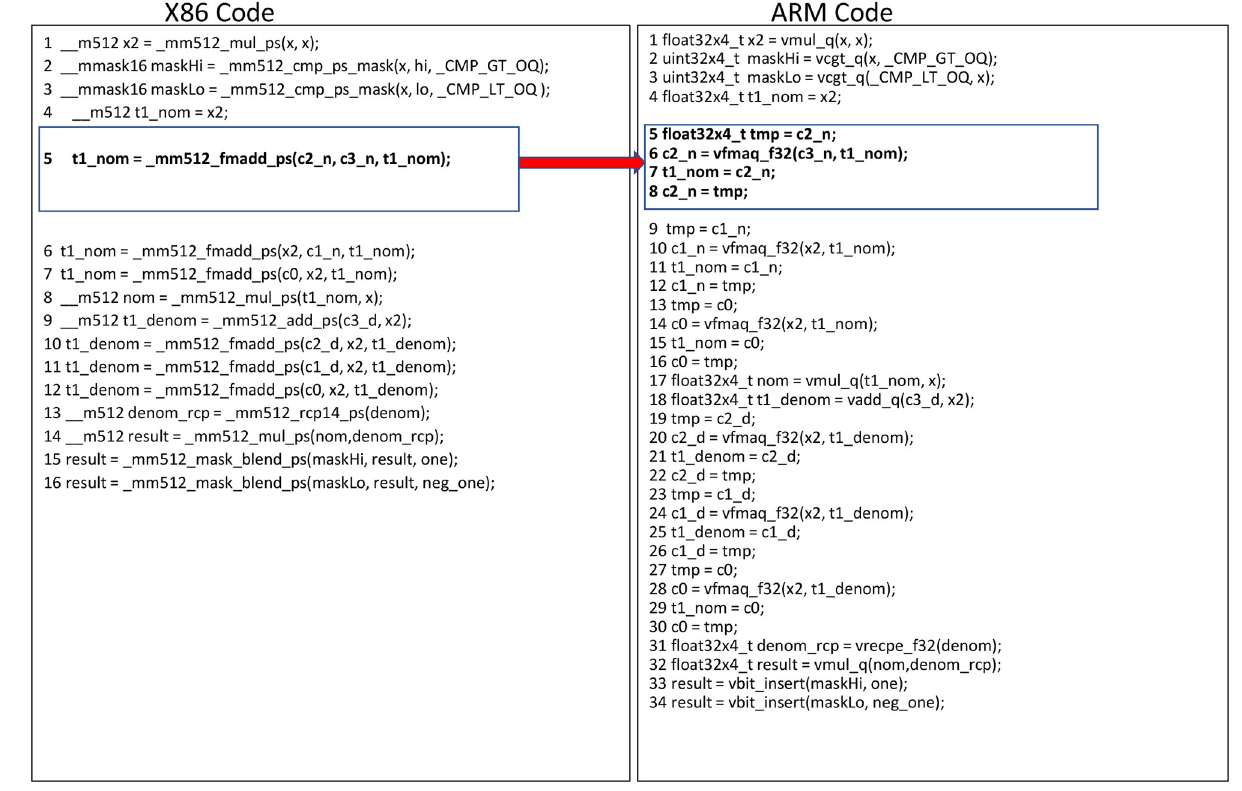
to relatively complex code, and as such we skip its